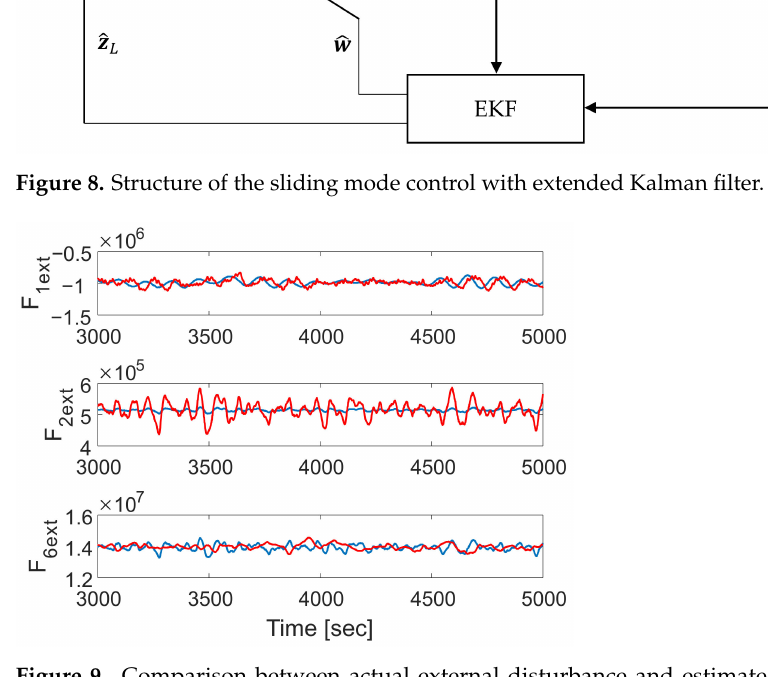
Figure 9. Comparison between actual external disturbance and estimated external disturbance calculated by EKF (blue: actual, red: